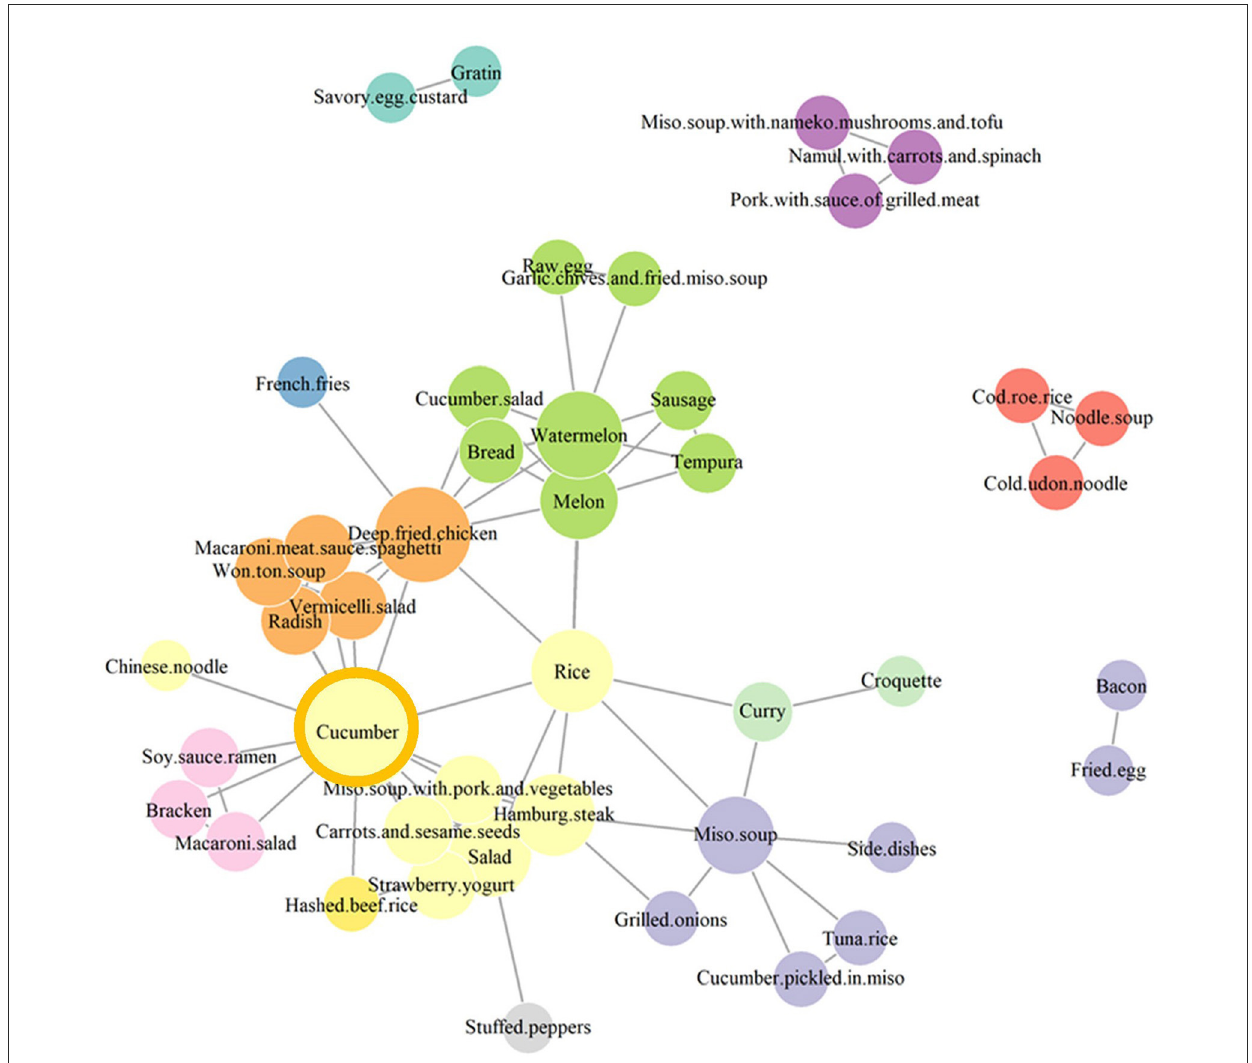
FIGURE3 Co-occurrence network of food items in drawings of fourth graders . The size of an item’s circle corresponds to the number of lines connecting it to other items. Unique colors are used to identify nodes defined by Jaccard similarity coefficients.